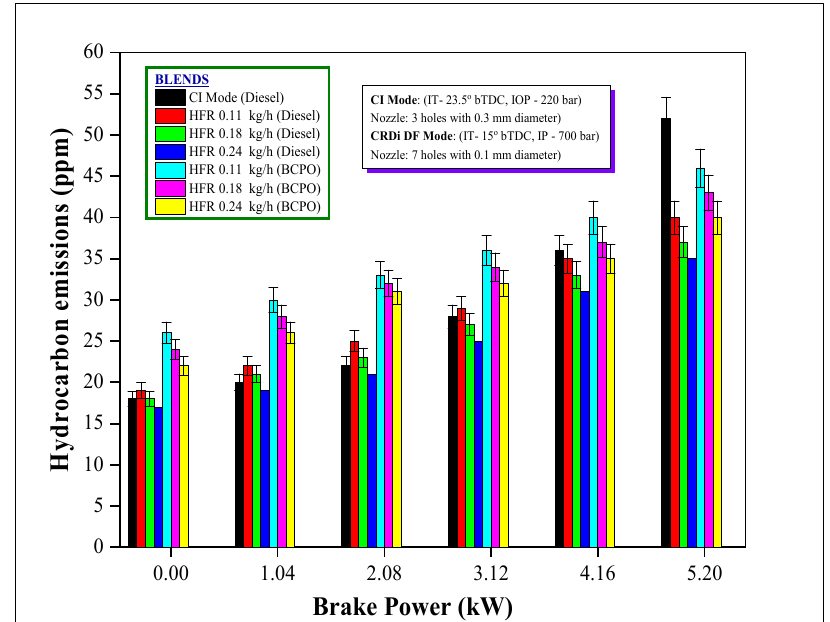
Figure 6. HFR and BP influence on CRDi engine HC emissions.